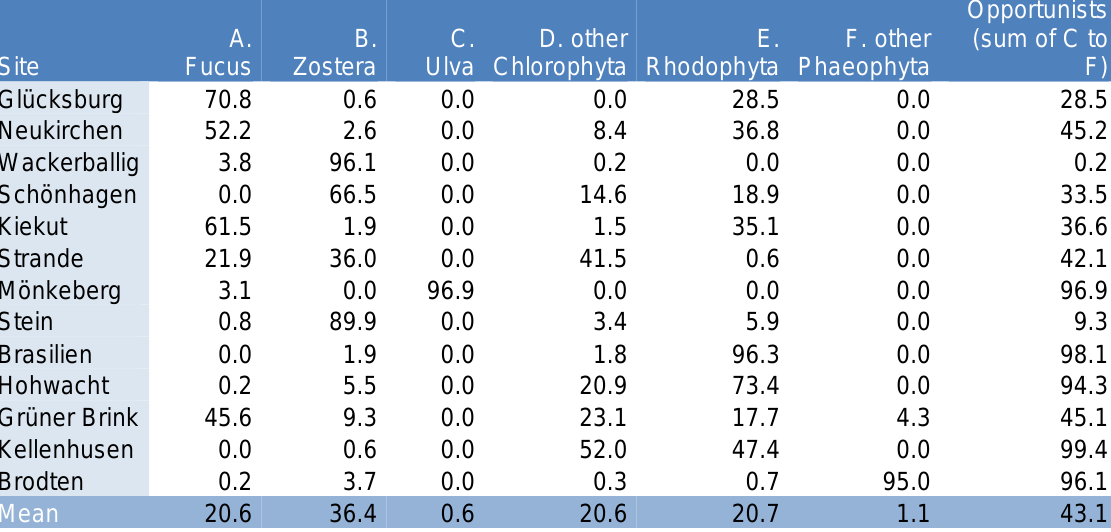
Table S1B: Relative contribution [%] of different macrophytes to dry weight of beach wrack sampled in August